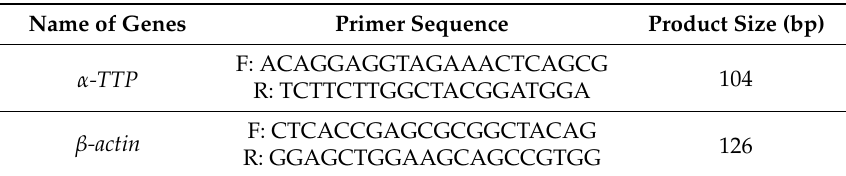
Table 4. Details of primers used for quantitative real-time